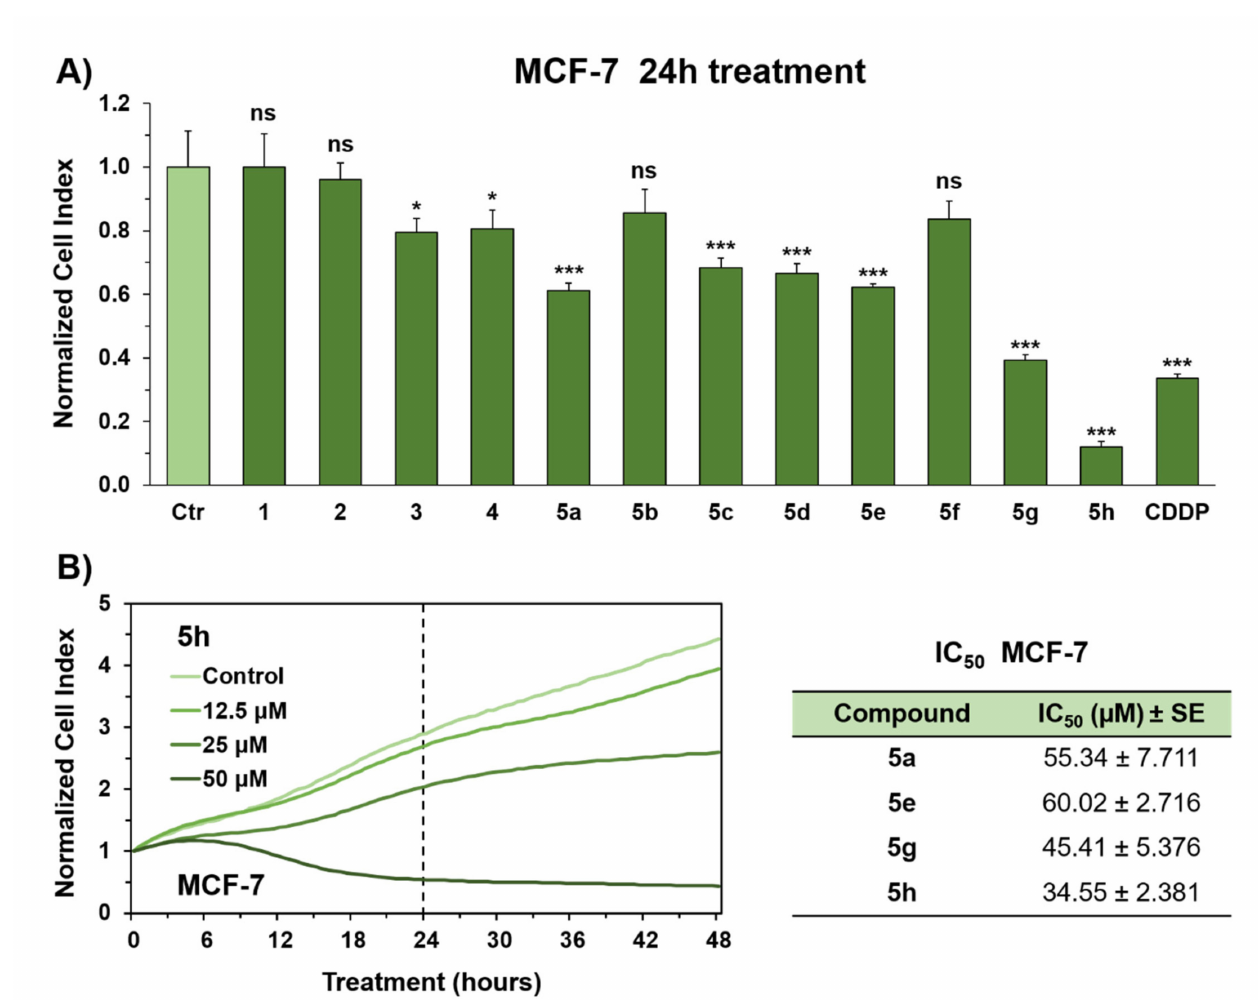
Figure 2. Real time monitoring of breast cancer MCF-7 cell viability after 24 h exposure to synthetic compounds 1 , 2 , 3 , 4 , 5a , 5b , 5c , 5d , 5e , 5f , 5g , and 5h and 0.5% dimethyl sulfoxide (DMSO) vehicle (control), using the xCELLigence System Real-Time Cell Analyzer. ( A ) Normalized Cell Index (NCI) variations of MCF-7 cancer cells after 24 h incubation with 0.5% DMSO vehicle (Ctr, control) and 50 µ M of cisplatin (CDDP), 1 , 2 , 3 , 4 , 5a , 5b , 5c , 5d , 5e , 5f , 5g , and 5h . NCI values are relative to controls treated with 0.5% DMSO vehicle. Data are presented as mean ± SD; n = 3. Statistical significances are referred to the DMSO control. Differences between groups were determined by analysis of variance (ANOVA) and Dunnett’s test was used for multiple comparisons with the control. * p < 0.05; *** p < 0.0001 ( B ) Left panel: Representative NCI traces of MCF-7 cells exposed to increasing concentrations (12.5, 25, 50 µ M) of 5h and 0.5% DMSO vehicle (control) for 48 h. Right panel: Half-maximal inhibitory concentration (IC 50 ) values ( ± standard error, SE) of 5a , 5e , 5g , and 5h against MCF-7 cells after 24 h drug exposure. The IC 50 value represents the concentration of each compound that reduces the NCI by 50%. Data are means of three independent